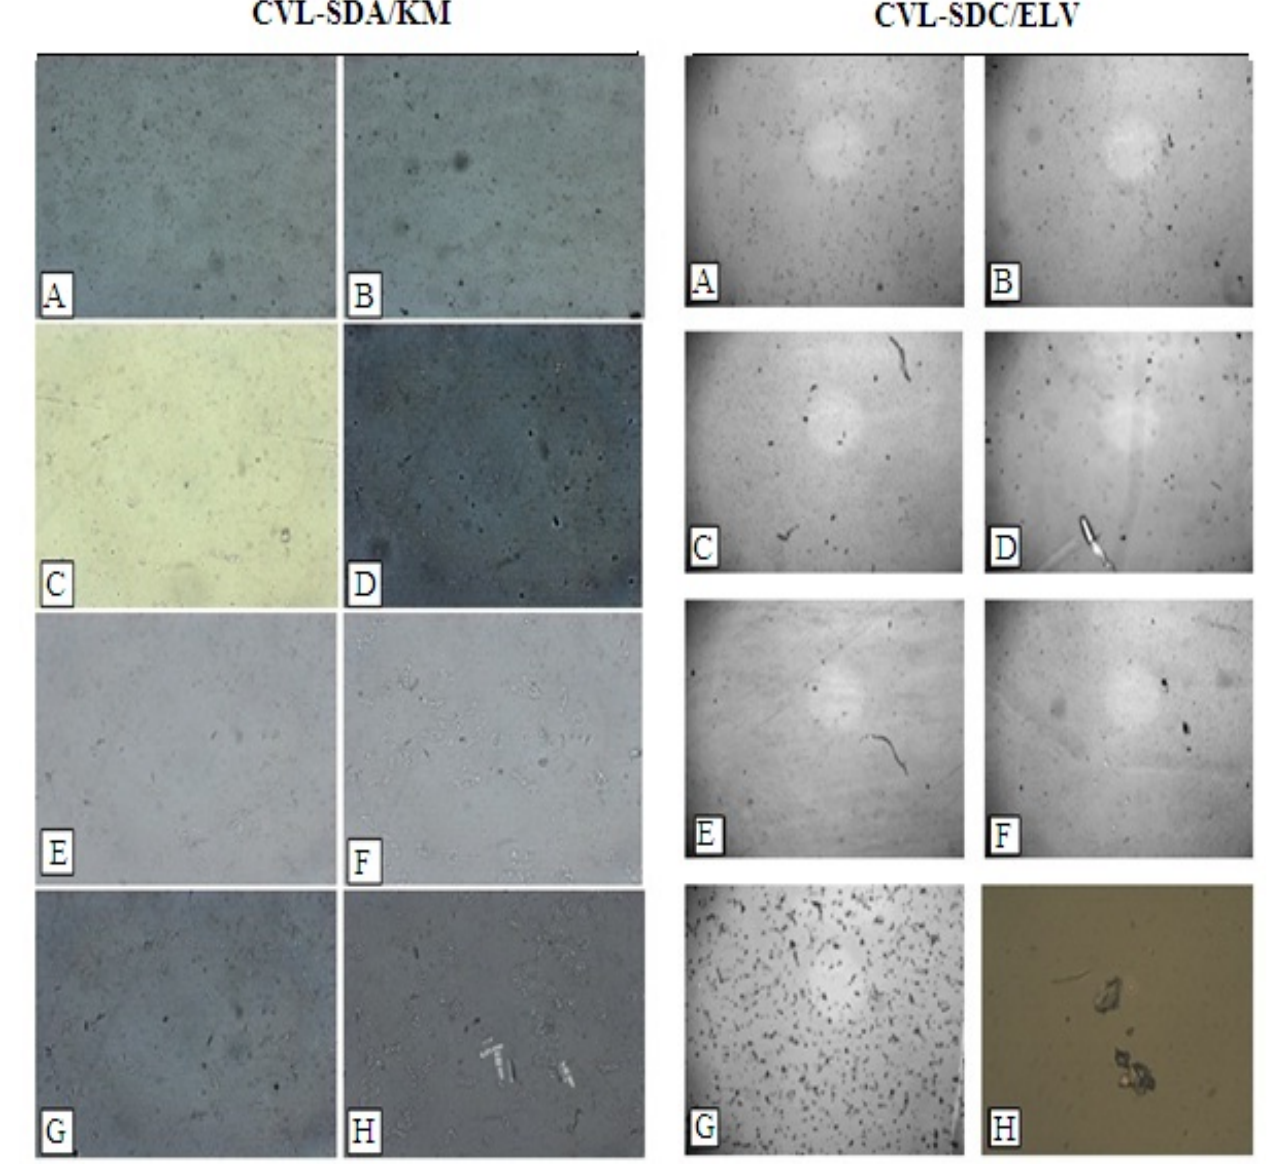
Figure 8. PLM images of CVL-SDs on time function ( A ) 0 min, ( B ) 20 min, ( C ) 40 min, ( D ) 60 min, ( E ) 100 min, ( F )140 min, ( G ) 180 min and ( H ) 24 hrs. ( E ) 100 min, ( F )140 min, ( G ) 180 min and ( H ) 24